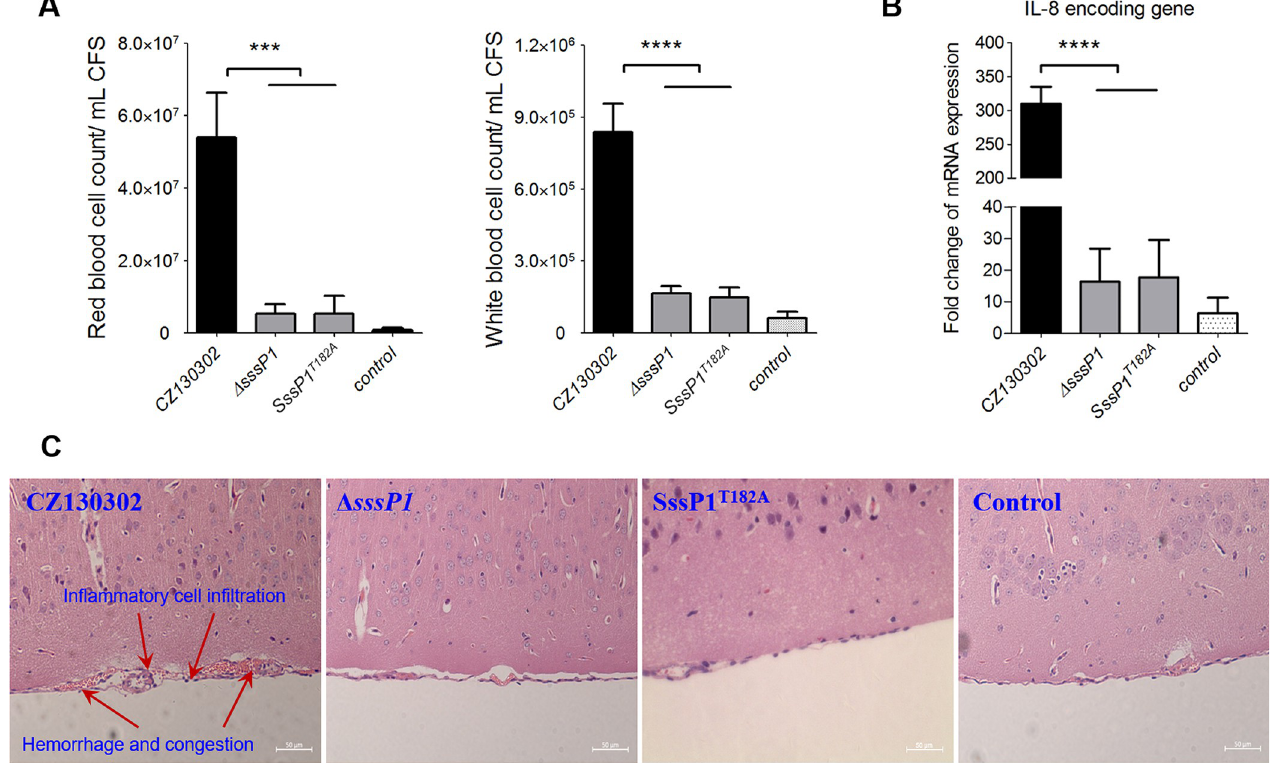
Fig 1. SssP1 is critical for S . suis to cause meningitis. Since the inoperability of constructing the complementary strain by reintroducing a 13,944 bp sssP1 gene, a mutant (SssP1 T182A ) with a stop codon at position 182 bp was constructed by artificially changing T to A, which was used as an alternative method to confirm that Δ sssP1 is a non-polar deletion mutant. (A) The red blood and white blood cell counts of cerebrospinal fluid (CFS) from the mice infected with the indicated strains. Data are represented as mean ± SEM of three independent repeats ( ���� P < 0.0001, ��� P < 0.001). (B) Transcriptional level of IL-8 encoding gene in the brains of the mice infected with the indicated strains. Data are represented as mean ± SEM of three independent repeats ( ���� P < 0.0001). (C) Histopathological analysis of the brains from the mice challenged with CZ130302, Δ sssP1 or SssP1 T182A . Scale, 50 μ m.